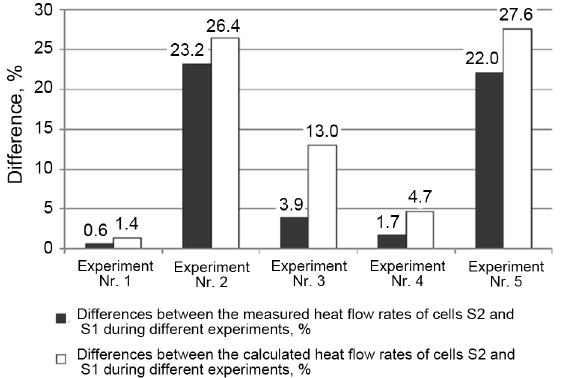
Fig. 7. Relative differences between the measured and calculat- ed heat flow rates of cells S2 and S1 during different experi-